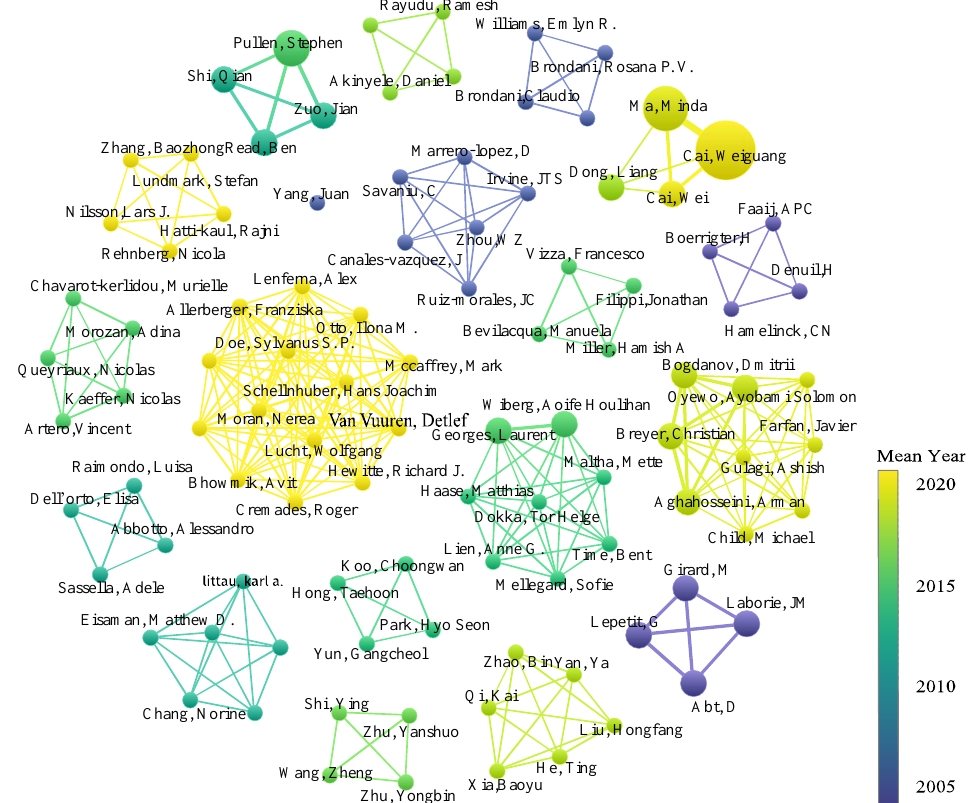
Figure 2. Overlay visualization map of co-authors. VOSviewer software was used to carry out overlay visual mapping for the TLS of the top 100 authors. In Figure 2, the node size represents the number of co-authored articles. The links between nodes represent collaboration, and a larger link width indicates closer collaboration between authors [63]. In Figure 2, we can see the contribution and